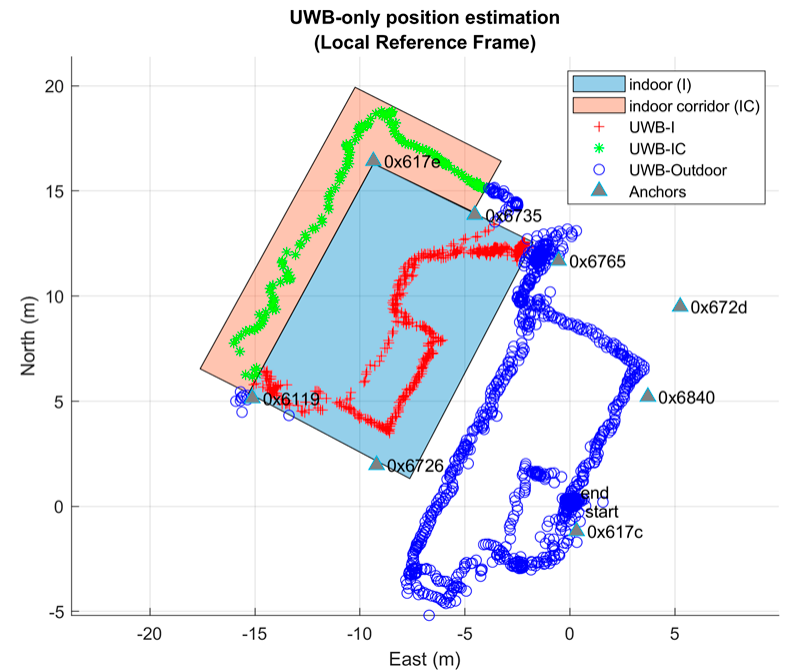
Figure 4. The horizontal positioning estimation obtained by the UWB only in real time.